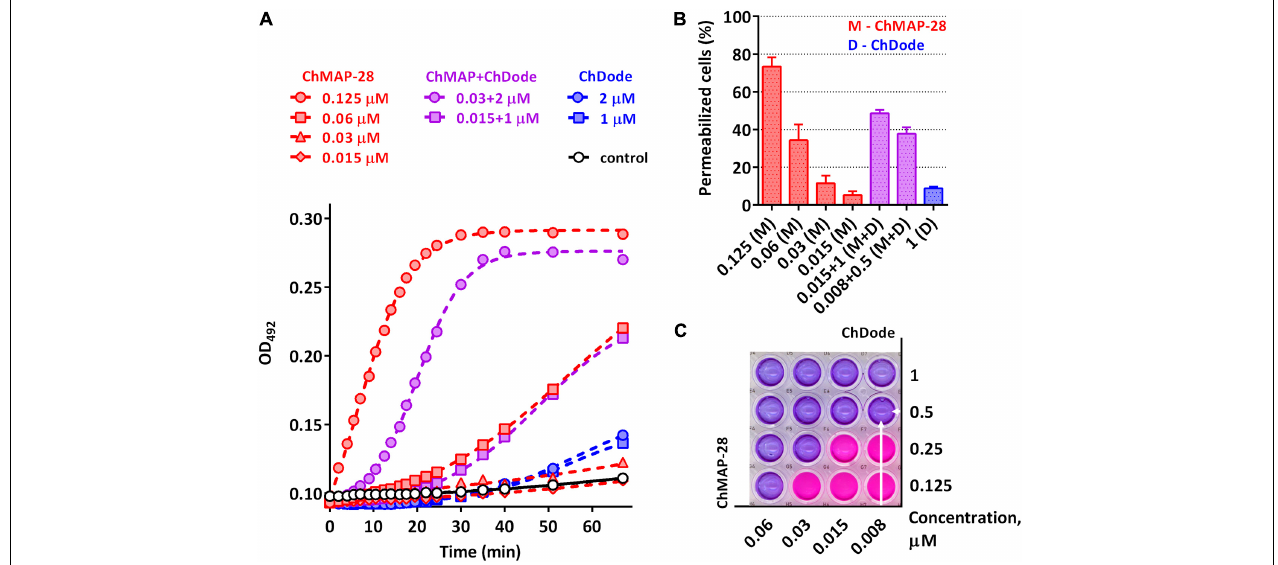
FIGURE 9 | (A) Kinetics of changes in E. coli ML-35p outer membrane permeability measured with the use of chromogenic marker – the products of nitrocefin (OD 492 ) hydrolysis. Comparative analysis of outer membrane permeability resulting from incubation with individual ChMAP-28, ChDode at various concentrations and their combination. Three independent experiments were performed, and the curve pattern was similar for the three series. (B) The ONPG testing for permeability of the cytoplasmic membrane of E. coli ML-35p. The graph shows effects of the peptides at different concentrations after 2 h. Data are the mean ± SD of two independent experiments. (C) The effect of the combined action of the peptides ChMAP-28 (M) and ChDode (D) against bacterial cells after incubation with resazurin. The arrows indicate the well with the lowest reproducible FICI. The result was reproduced in three independent experiments.